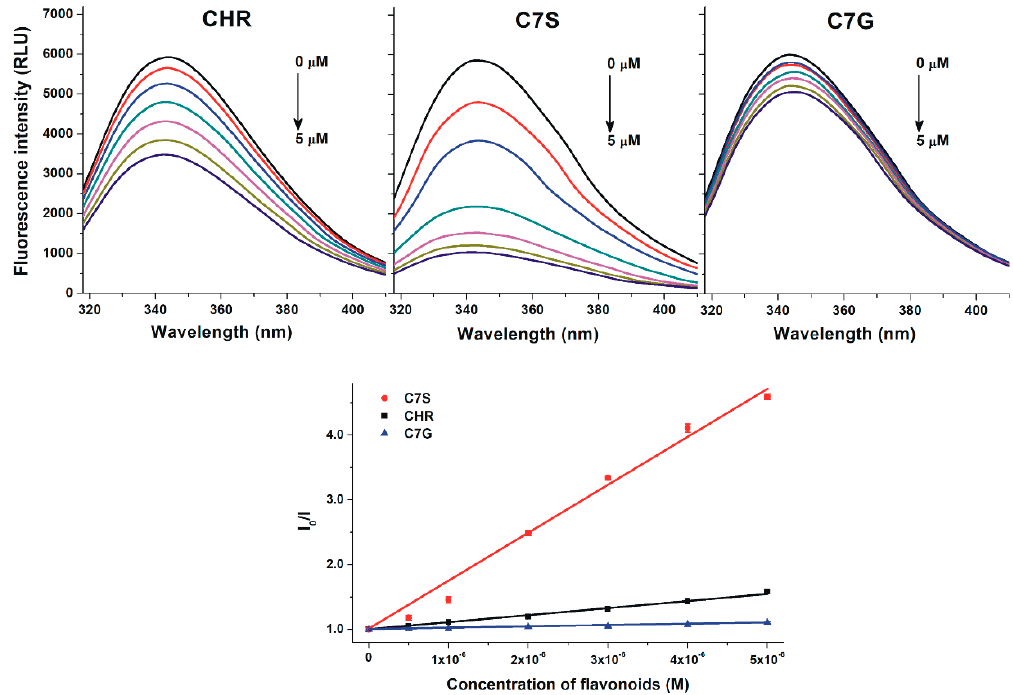
Figure 3. Top graphs: Fluorescence quenching effects of chrysin (CHR; left), chrysin-7-sulfate (C7S; middle), and chrysin-7-glucuronide (C7G; right) on BSA (2 µmol/L) in PBS (pH 7.4; λ ex = 295 nm, λ em = 340 nm). Bottom graph: Stern–Volmer plots of flavonoid–BSA complexes.